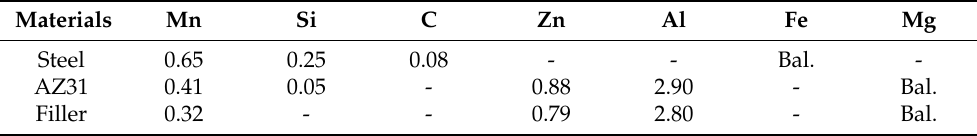
Table 1. The main chemical composition of the parent metals